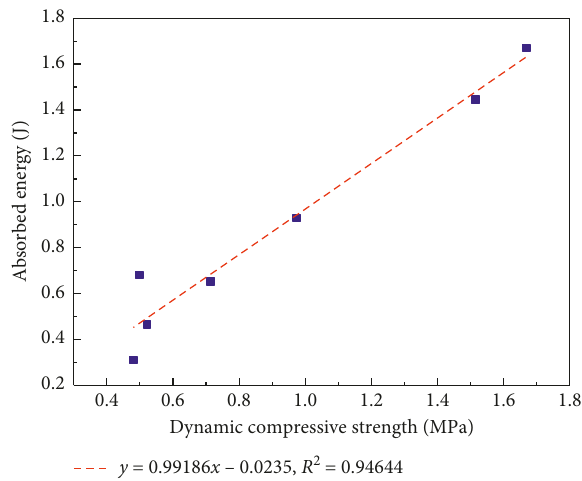
Figure 8: Fitted curve of dynamic compressive strength and absorbed